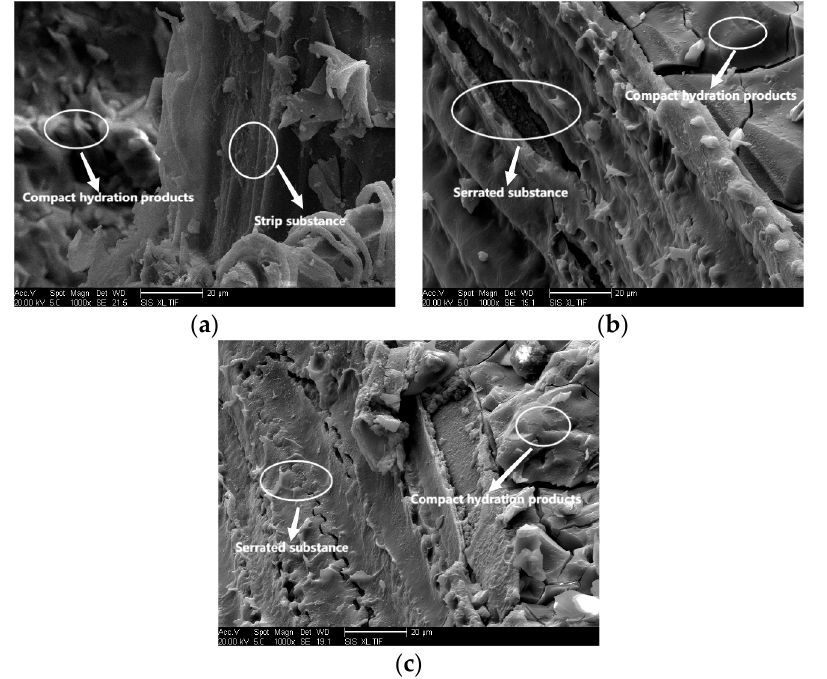
Figure 13. SEM of specimens. ( a ) With wheat straw; ( b ) With rice straw; ( c ) With corn